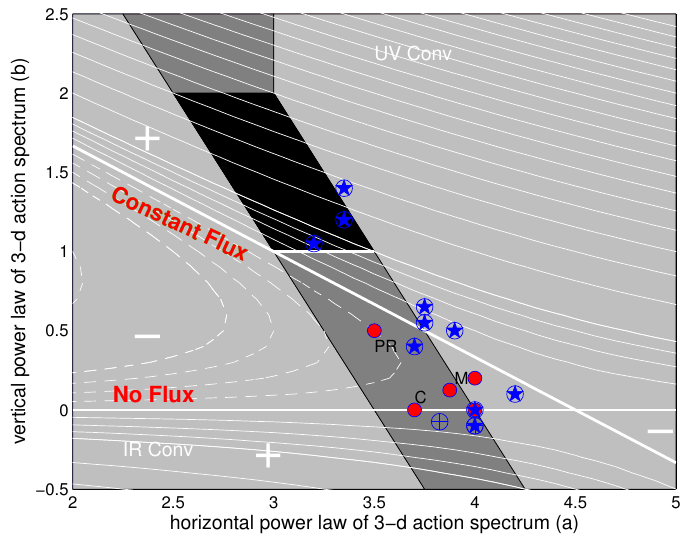
Figure 1. Estimates of frequency and vertical wavenumber power laws cast in terms of a three | m | − b with horizontal wavenumber magnitude k dimensional action spectrum n ( k h , m ) ∝ k − a h and h vertical wavenumber m and overlain on a theoretical paradigm map. Blue symbols represent power law fits to ocean observations. See [6] (their Figure 36) for the identification of the field programs. Filled circles represent scale-invariant stationary states identified by [8] (PR), a convergent numerical solution determined in [9] (C), the GM76 spectrum at ( a , b ) = ( 4,0 ) and curve fits to two possible dynamic balances identified in [5] (M). Thin white contours are proportional to the action tendency in the Fokker–Plank with + − symbols denoting the sign. The [5] states lie in a part of parameter space with decreasing spectral amplitude, which then requires an unidentified source to remain in a steady state. Overlain as thick white lines are the induced diffusion stationary states with the constant flux solution trending diagonally and the no-flux solution lying horizontal along b = 0. Adapted from [6], their Figure